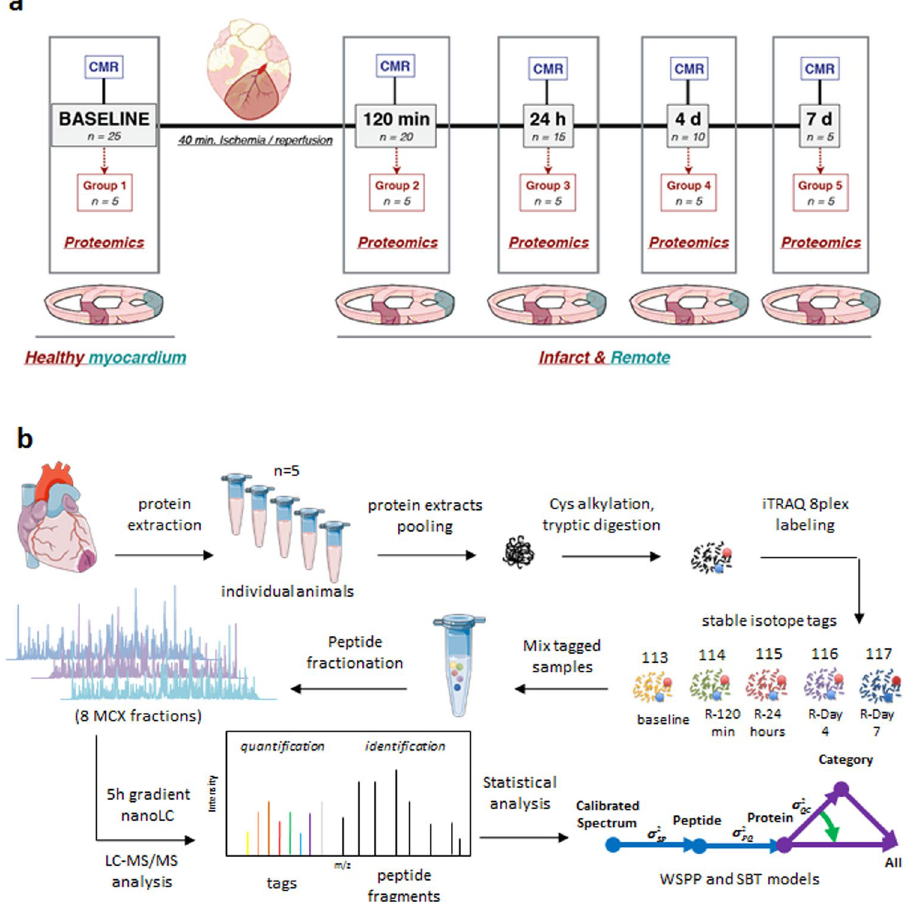
Figure 1. Study design. ( a ) The study population comprised 5 groups of pigs (n = 5/group). Groups 1 to 5 were used for the histopathological characterization of myocardial tissue changes during the first week after ischemia/reperfusion (I/R). CMR (cardiac magnetic resonance) scans included cine steady-state free-precession (SSFP) sequences to provide high quality anatomical references and functional information. CMR scans were performed at all follow-up stages until sacrifice, so that animals sacrificed at day 7 underwent baseline, 120 min, 24 h, day 4, and day 7 CMR. CMR and myocardial water content data from animals in groups 1 to 5 have been reported previously 18 . ( b ) For proteomic analysis, remote and ischemic tissue samples from these animals were processed for protein extraction, tryptic digestion, multiplexed stable isotope labeling, and fractionation followed by nano-liquid chromatography-tandem mass spectrometry (nanoLC-MS/MS) and systems biology analysis. Graphical elements in panel b were adapted from the Servier Medical Art Powerpoint image bank. Servier Medical Art by Servier (http://www.servier.com/Powerpoint-image-bank) is licensed under a